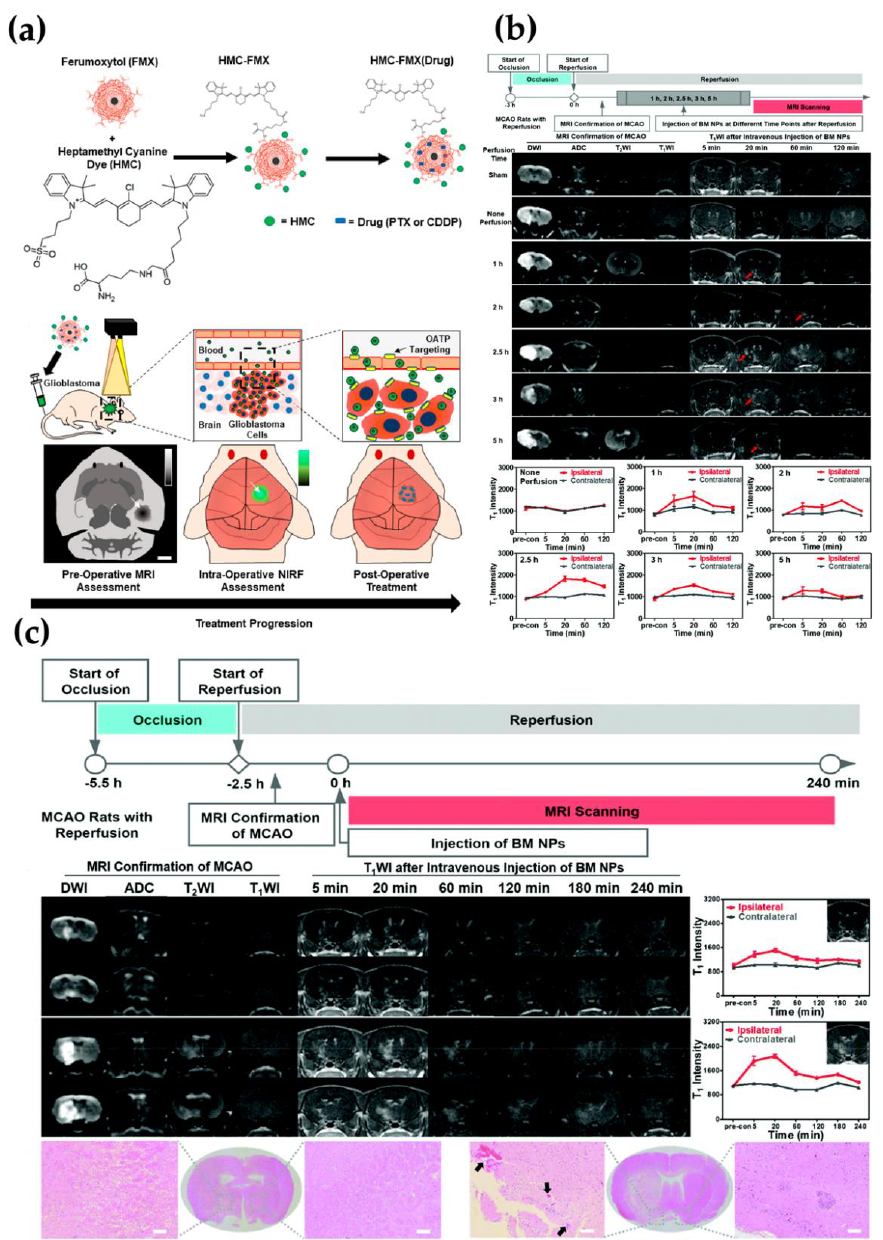
Figure 3. ( a ) HMC–FMX facilitates GBM tumor detection and drug delivery across the BBB, permis- sion from [104]. Copyright (2020) American Chemical Society; ( b ) MR imaging of BBB permeability in MCAO rats without perfusion or with different perfusion time points (1, 2, 2.5, 3, and 5 h) post- injection of BM NPs, permission from [80]. Copyright (2021) Royal Society of Chemistry; ( c ) BBB permeability imaging indicated by the BM NPs in MCAO rats with or without HT, permission from [80]. Copyright (2021) Royal Society of Chemistry.